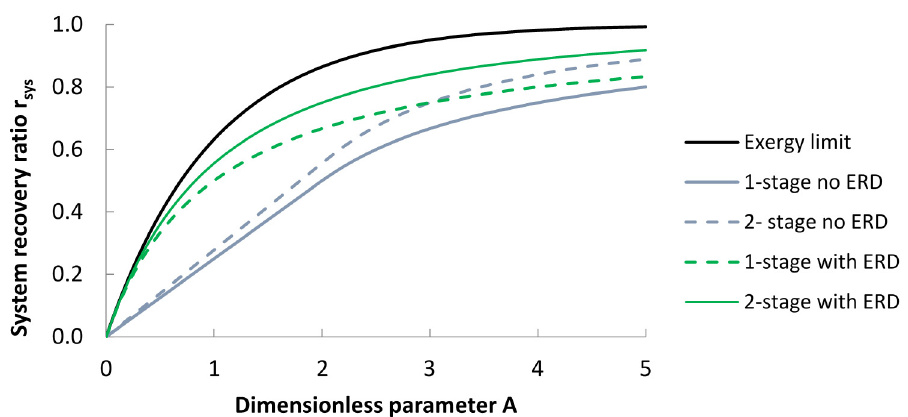
Figure 4. Maximum possible values of system recovery ratio r sys using a reversible geothermal heat engine to drive the desalination process, based on Table 1. Exergy limit is for an ideal reversible RO system (Equation (8)). Lower curves are for theoretical 1- and 2-stage RO systems with and without energy recovery device (ERD), with only essential losses taken into account. Parameter A is defined by Equation (9) (or by Equation (15) once real losses are taken into